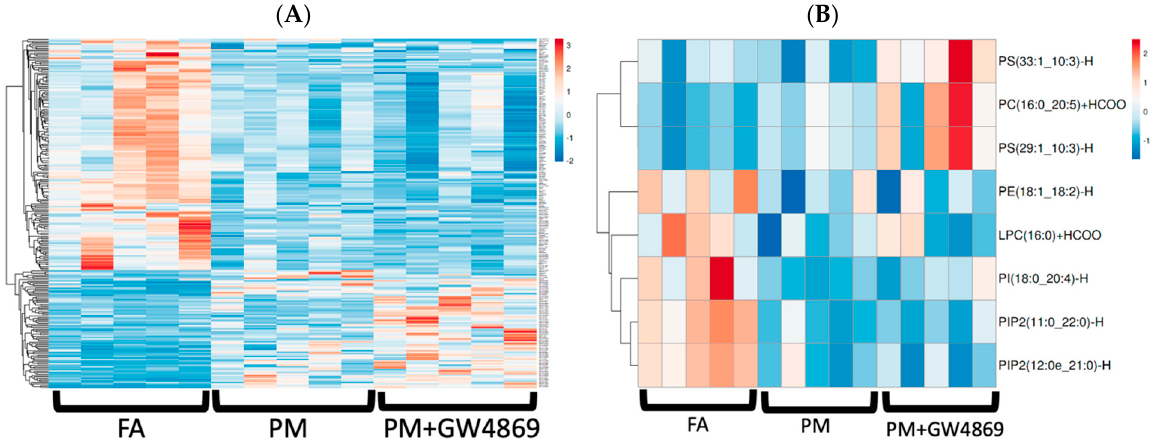
Figure 6. Exosome lipidomics. ( A ) Positive-ion, serum-borne exosome lipidomics. ( B ) Negative-ion serum-borne exosome lipidomics. For lipids with a VIP value >1.5, differential expression demonstrated in the heatmaps was based on a one-way ANOVA analyzed between treatment groups. Statistically significant lipids were determined at p ≤ 0.05.